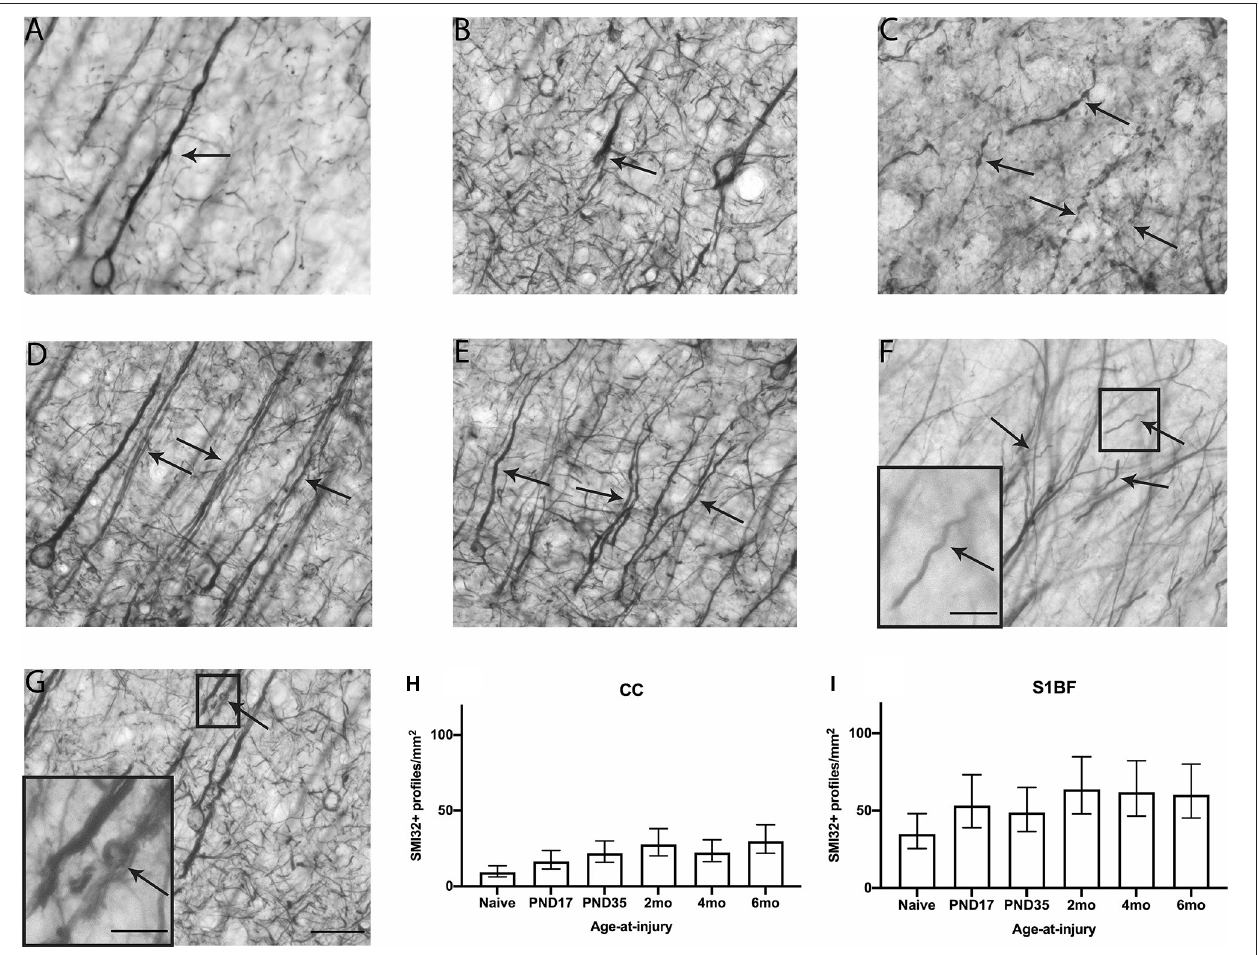
FIGURE 3 | SMI32 dendritic profiles were quantified in the CC and S1BF. Indicative images of healthy dendrites (A) and dendritic pathology visualized by SMI32 immunohistochemistry were taken in the primary sensory barrel field (S1BF) of rats brain-injured at 6-months of age. Quantitative analysis included bulbs (B) , blebbing (C) , thickened axons (white arrows; D ), or undulated axons (black arrows; D ), thickened and undulated axons (E) , corkscrews (F) , and rings (G) indicated by the arrows (scale bar = 50 µ m, inset = 10 µ m). Dendritic pathology was expressed as the number of SMI32 + profiles/mm 2 (mean ± 95%CI) in the corpus callosum (CC) and S1BF. Significantly more SMI32 + profiles were observed following mFPI compared to naïves in the CC (H) , regardless of whether the TBI was recent or remote. However, a greater extent of SMI32 pathology in the S1BF (I) compared with naïves was only evident with a more recent TBI (see Table 3 ).